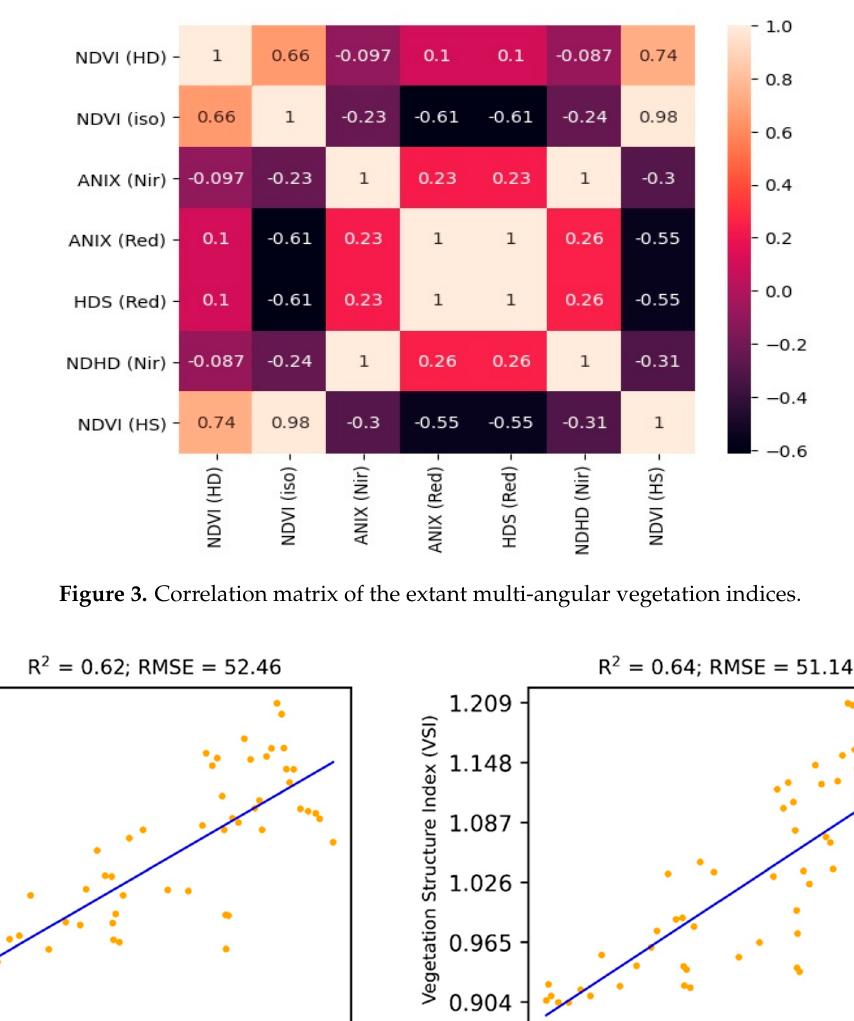
The effects of the view angles (Fore-scattering versus Back-scattering) on the above- ground biomass have been shown in Figure 5.